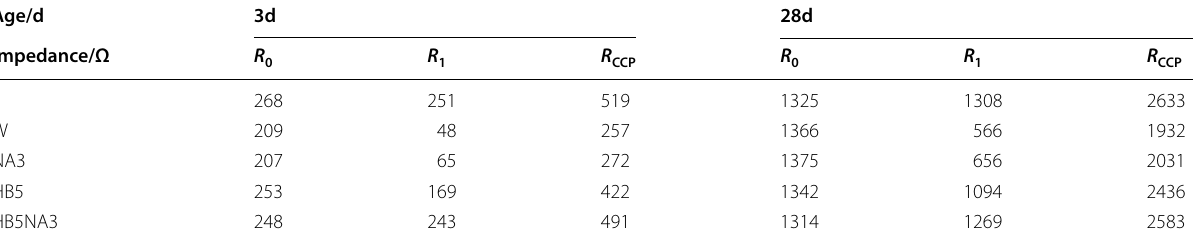
Table 6 Impedance parameters of different samples Age/d 3d